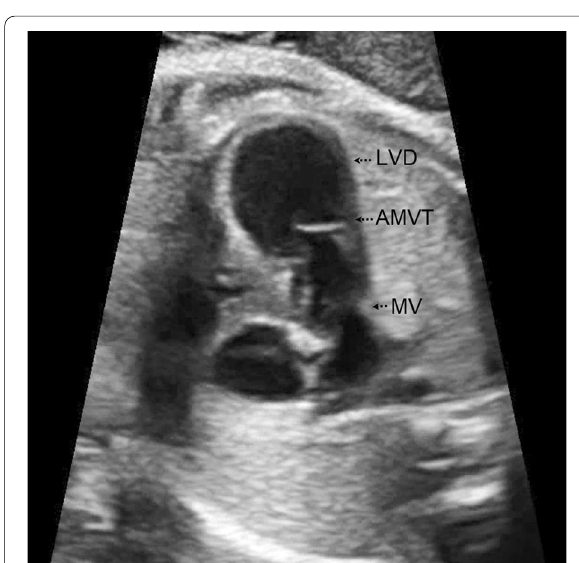
Fig. 2 Four chamber view of the heart showing the accessory mitral valve tissue (AMVT) and the outpouching of left ventricular diverticulum (LVD) at 26 weeks of